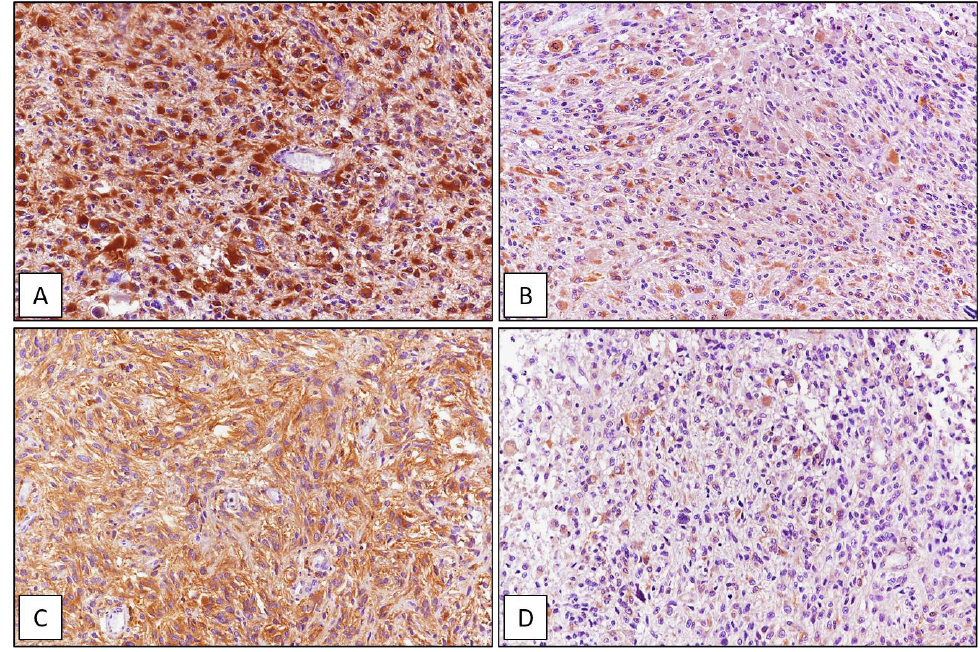
Figure 9. GBM tissue sample. High ( A ) and low ( B ) immunohistochemical expression of ATG7; high ( C ) and low ( D ) immunohistochemical expression of ATG4 (immunoperoxidase staining; original magnifications 200×).